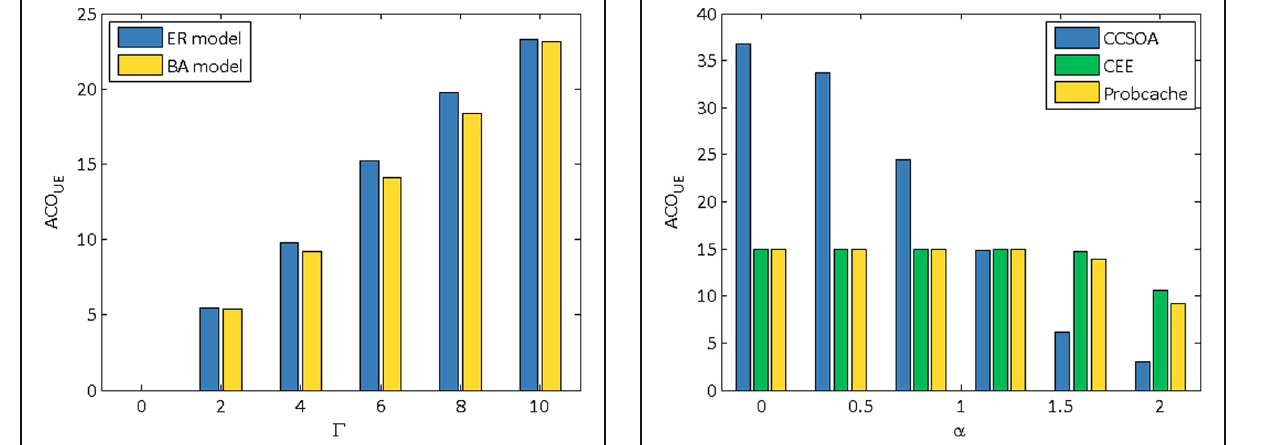
(cid:3) T UE to ACO with different